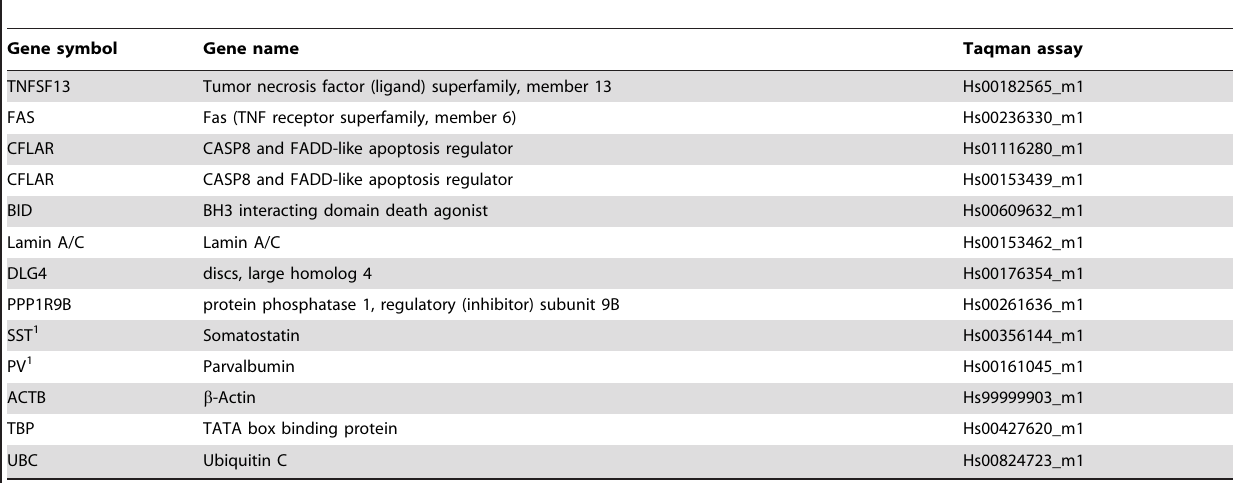
Table 1. Genes analyzed with ABI Taqman Gene Expression assay part